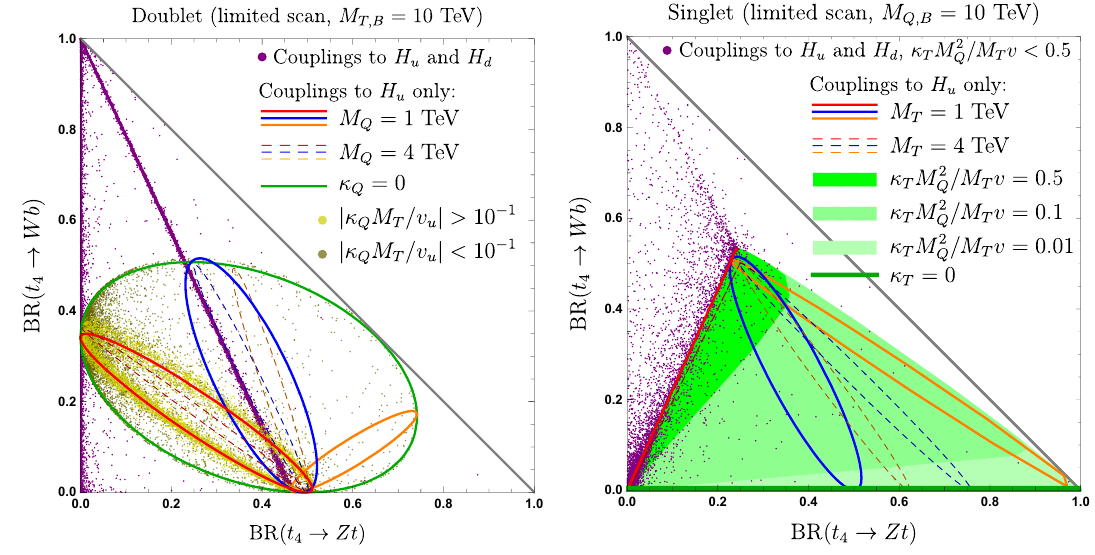
Figure 3 . The left (right) panel shows the allowed branching ratios of a mostly doublet (singlet) t 4 . The green ellipse (line) is obtained for (cid:20) Q = 0 ( (cid:20) T = 0). The red, blue and orange ellipses show three cases of how a (cid:20) Q = 0 ( (cid:20) T = 0) point moves towards the Goldstone boson equivalence limit as (cid:20) Q ( (cid:20) T ) is increased. Solid and dashed lines correspond to M T = (1 ; 4) TeV ( M Q = (1 ; 4) TeV). Purple points correspond to a coarse scan of the whole parameter space. For the doublet case, yellow (green) points correspond to j (cid:20) Q M T =v u j > 10 (cid:0) 1 ( j (cid:20) Q M T =v u j < 10 (cid:0) 1 ); for the singlet case, the shaded green regions show the e(cid:11)ect of decreasing (cid:20) T M 2 = ( M T v Q